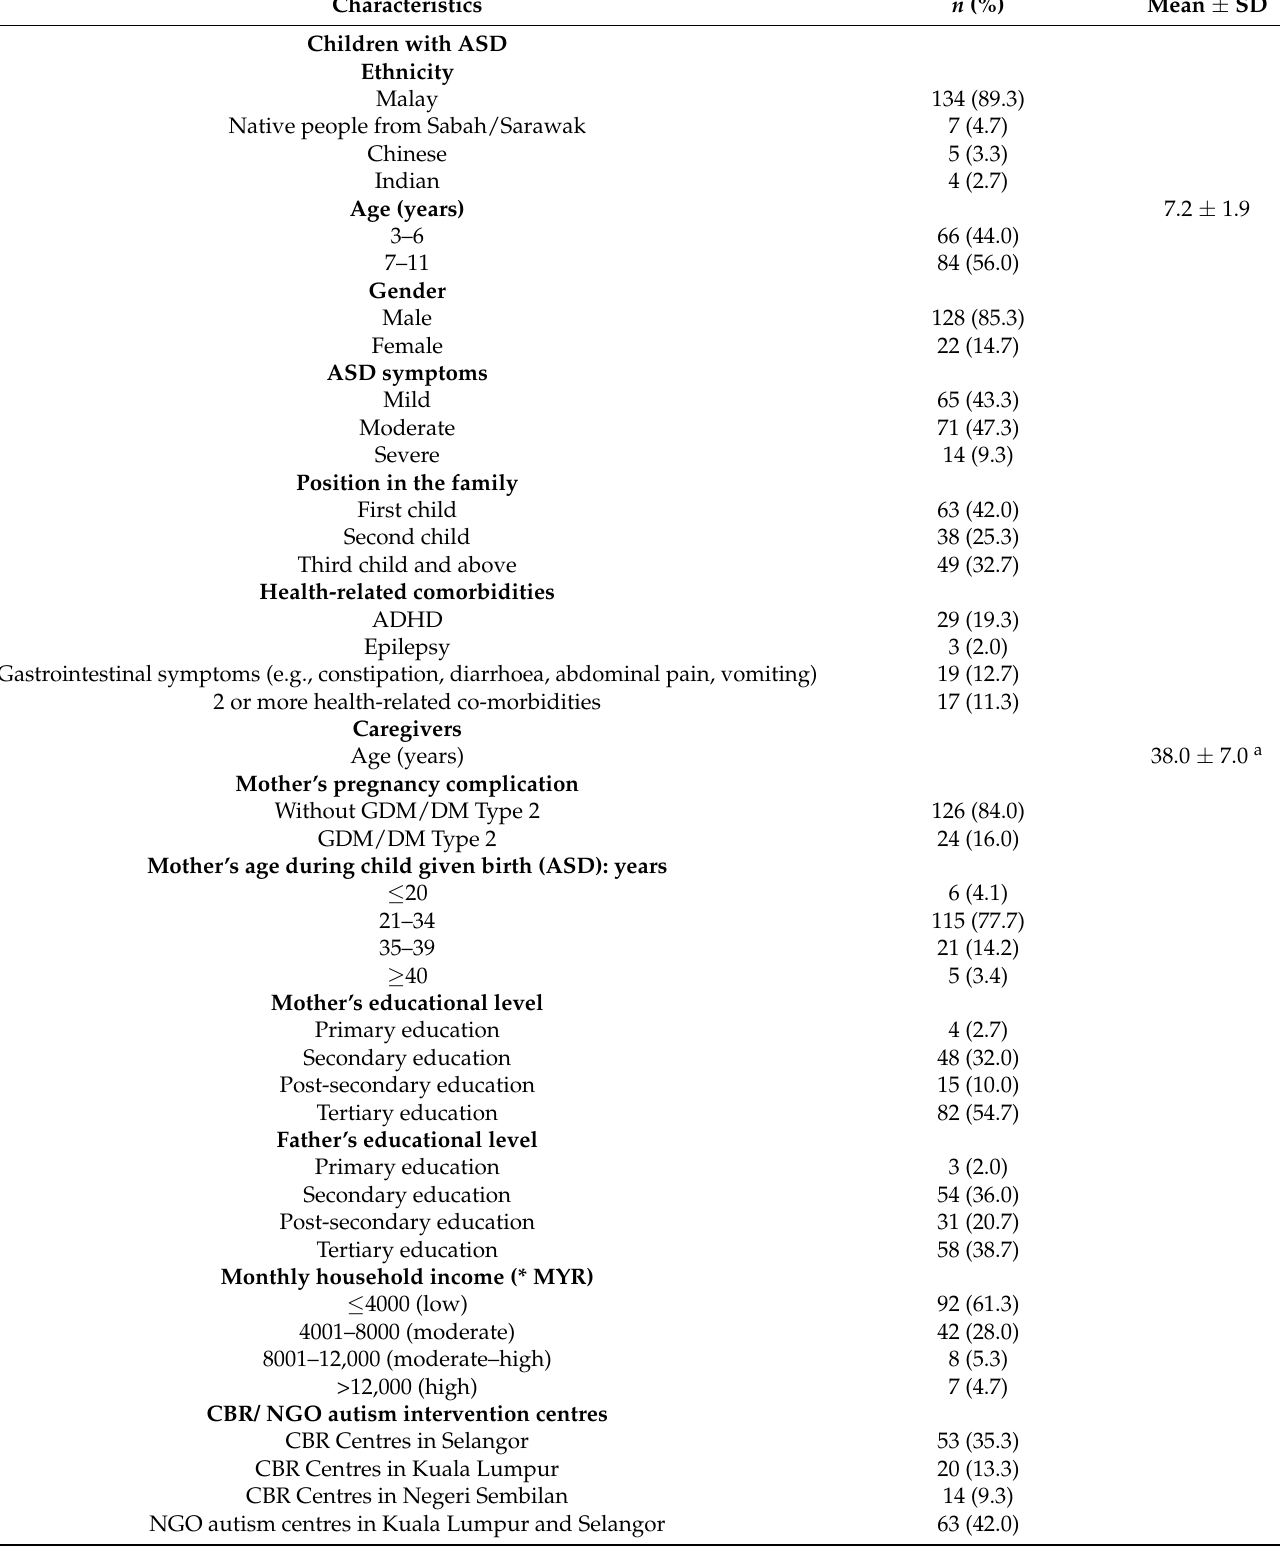
Table 1. Sociodemographic characteristics of children with ASD and their caregivers ( n = 150).